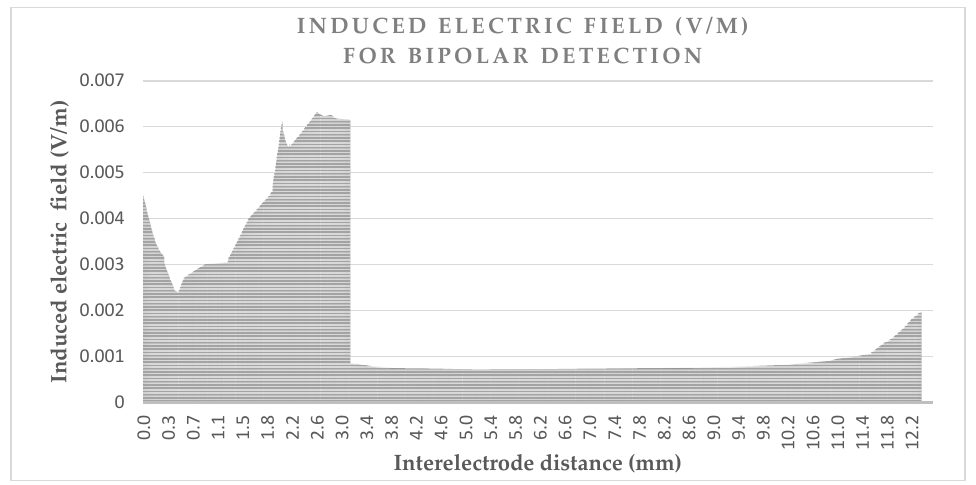
Figure 4. Induced electric field (V/m) between the electrodes (mm) for the bipolar detection of a pacemaker implanted to Ansoft 2 mm (grounded), due to the vertical electric field exposition (1 kV/m at 50 Hz).